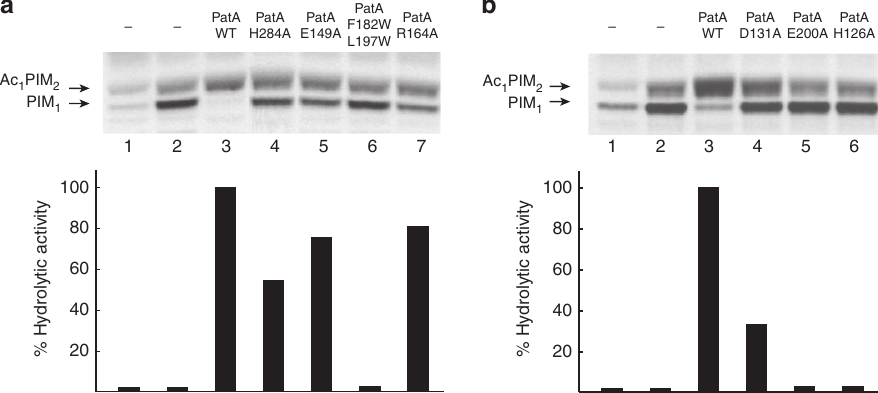
Figure 5 | Enzymatic activity of selected PatA variants. ( a ) In the upper panel, the acyltransferase activity of purified PatA and variants involved in substrate binding are shown (see Supplementary Fig. 9 for duplicates). Reaction mixtures contained crude membranes from M. smegmatis mc 2 155 and GDP-[ 14 C]-mannose as a tracer (lane 1), supplemented with PimA (lanes 2–7) and palmitoyl–CoA (lanes 3–7) and purified PatA (lane 3), PatA-H284A and analysed by TLC and autoradiography as described in Methods section. In the lower panel, the hydrolytic activity against palmitoyl–CoA is shown. ( b ) In the upper panel, the acyltransferase activity of purified PatA and variants involved in catalysis are shown (see Supplementary Fig. 9 for duplicates). Reaction mixtures contained crude membranes from M. smegmatis mc 2 155 and GDP-[ 14 C]-mannose as a tracer (lane 1), supplemented with PimA